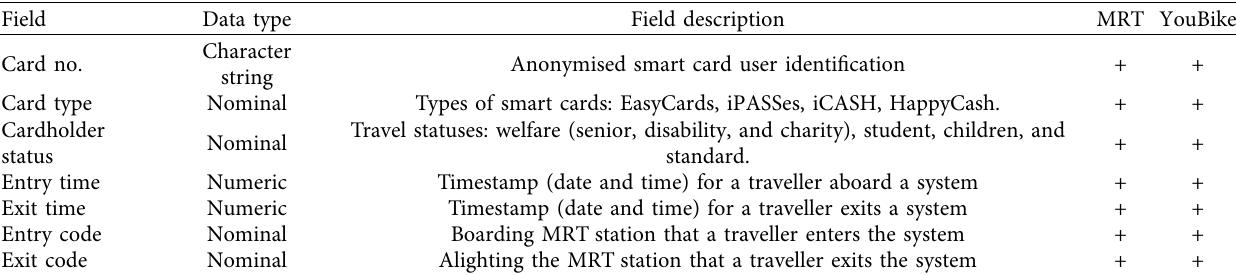
Table 1: The easy card transaction data format for the MRT and YouBike in the study.